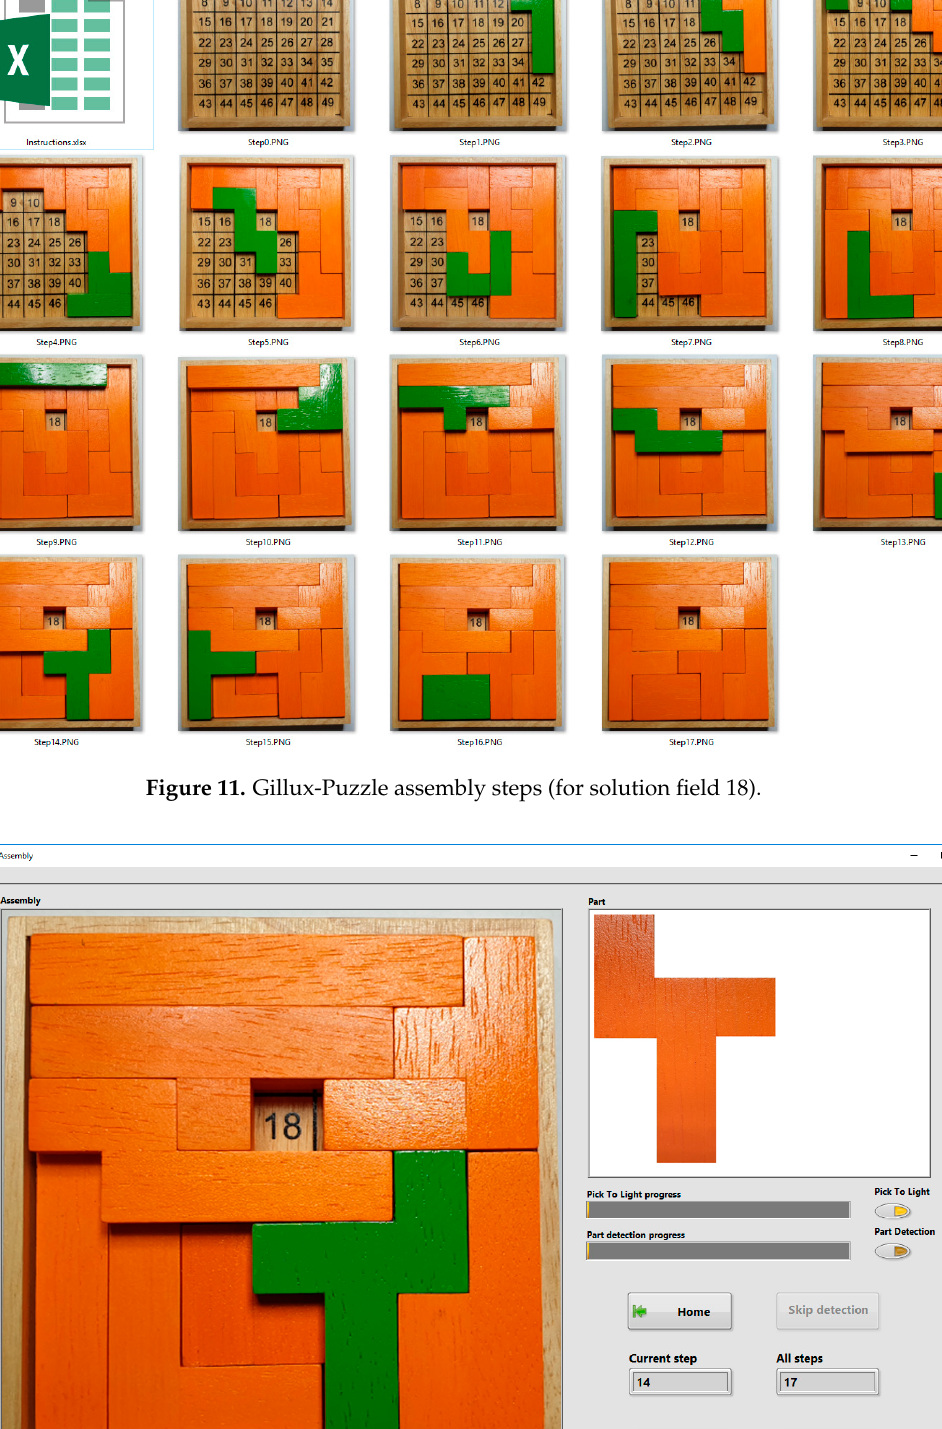
Figure 13. PTL modules (Gillux-Puzzle, solution field 18, step 14/17).